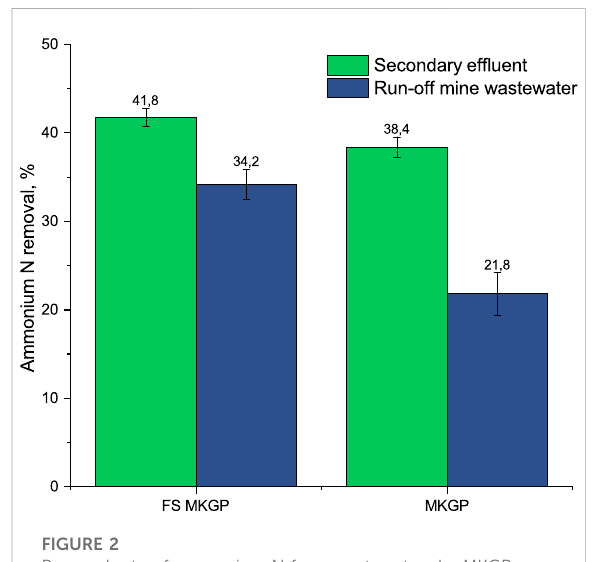
FIGURE 2 Removal rate of ammonium N from wastewaters by MKGP and FS MKGP in a batch mode: 5 g of adsorbent with particle size 0.25 – 1 mm, 1 h agitation time, pH 6.8 ( n = 3, p =